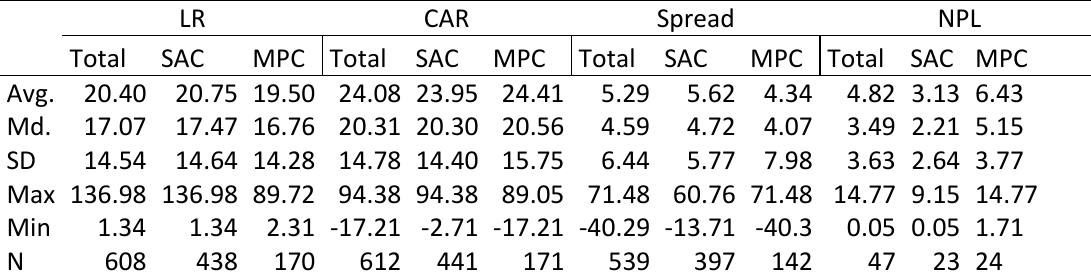
Table 3: Risk Measurement Ratios of Entire Sample (in percent) LR CAR Spread NPL Total SAC MPC Total SAC MPC Total